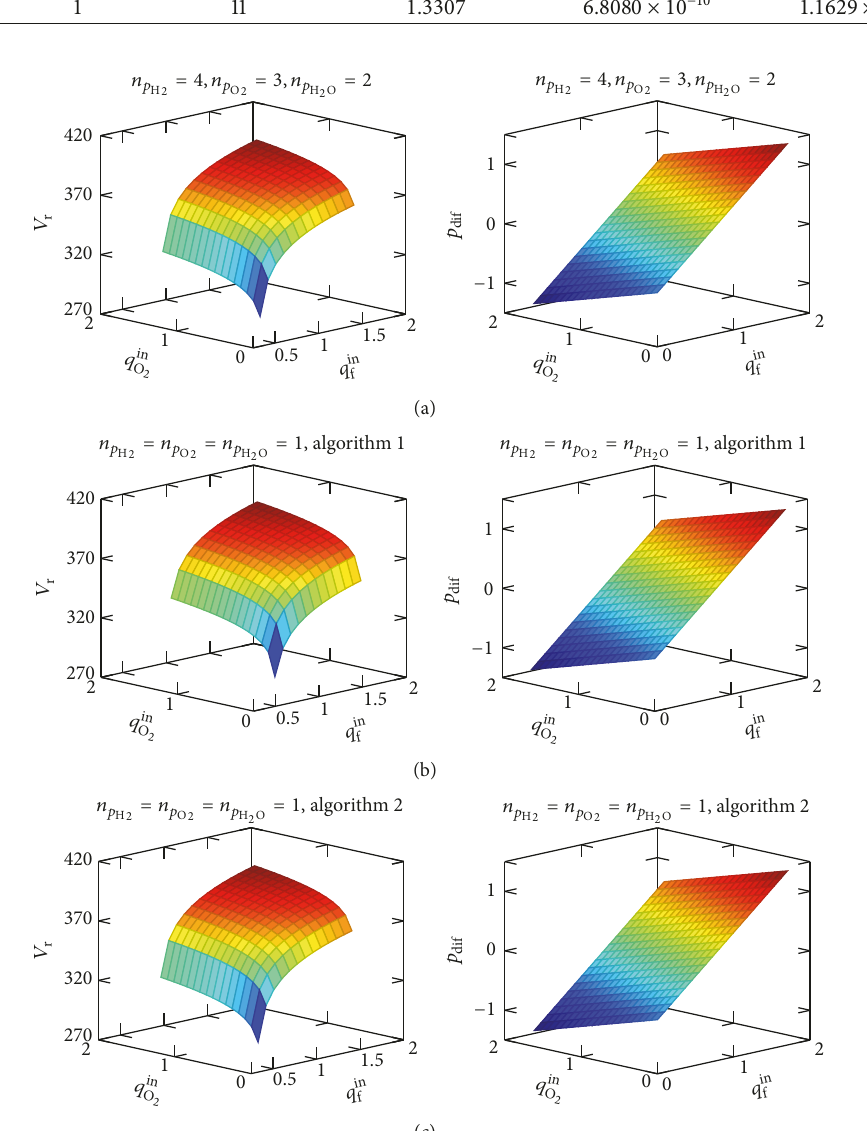
= 4 , 𝑛 = 3 , 𝑝 O 2 H 2